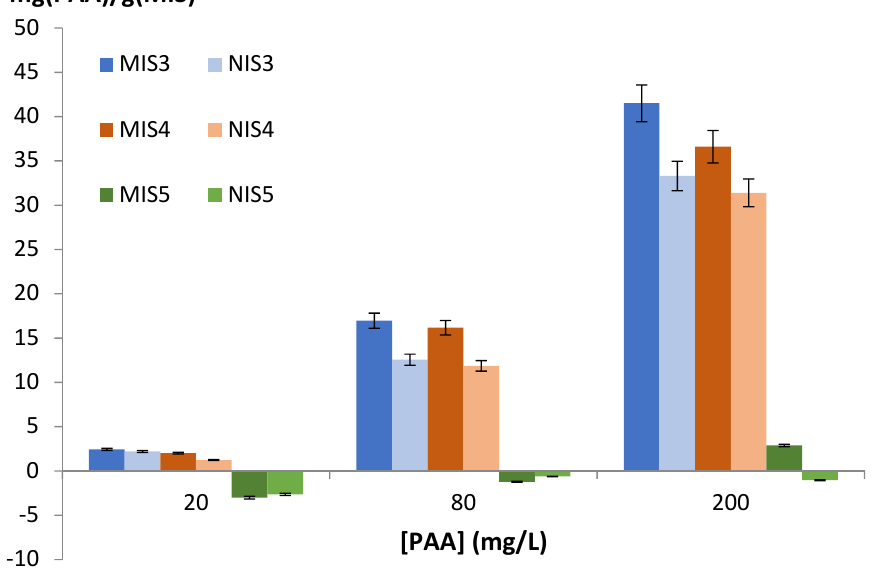
Figure 1. Adsorbed PAA/g of polymer vs. initial concentration in water/EtOH (90/10; v / v ). Error bars represent standard deviation. MIS are the imprinted polymers, NIS the non-imprinted poly- mers.